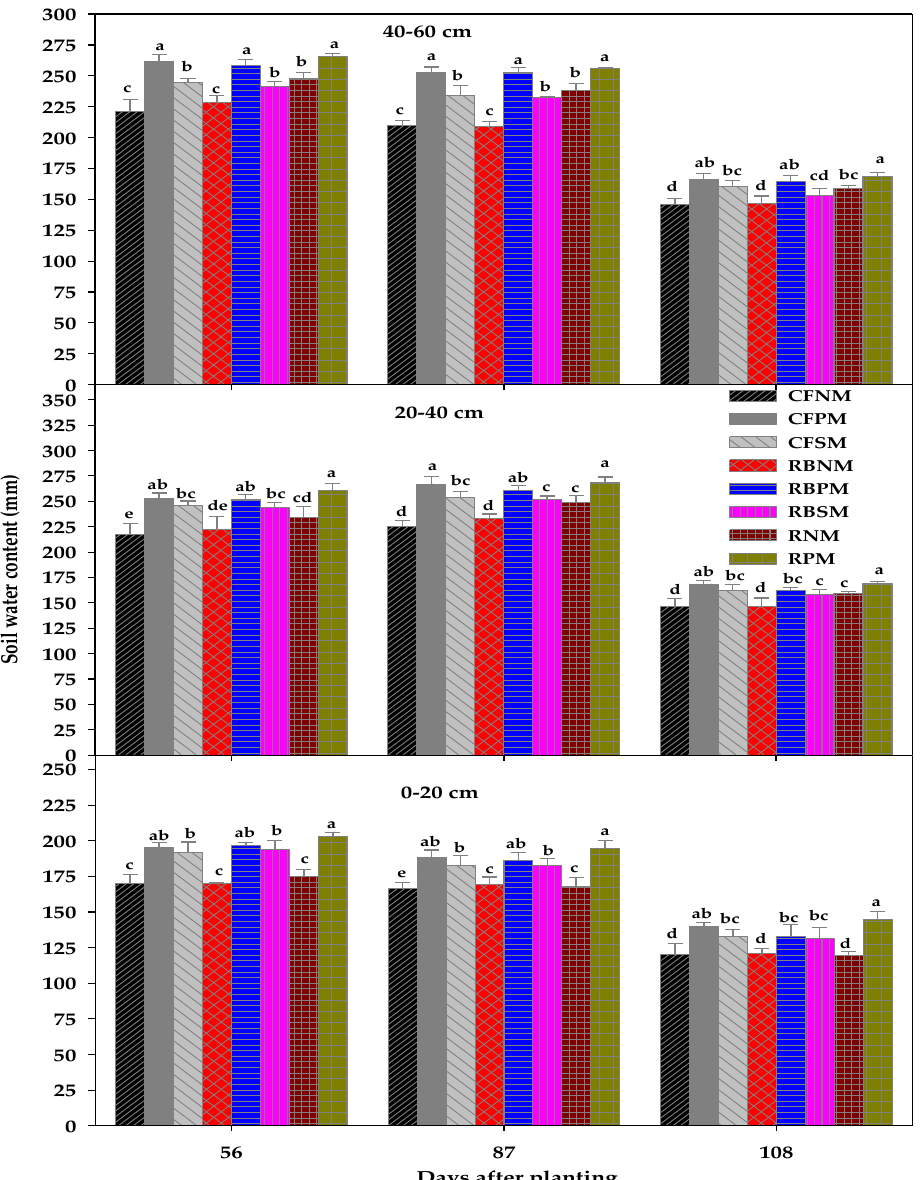
Figure 4. Effects of different planting patterns under full irrigation rate (1.00 ET) on soil water storage before irrigation at a 20 cm depth interval within 0–60 cm over two growing seasons at different durations (in days) after sowing. Conventional flat planting (CF) without mulching (CFNM); CF with plastic film mulch (CFPM); CF with wheat straw mulch (CFSM); raised-bed planting (RB) without mulch (RBNM); RB with plastic film mulch (RBPM); RB with wheat straw mulch (RBSM); ridge–furrow planting (RF) without mulch (RFNM); and RF with plastic film mulch on both ridges and furrows (RFPM). Bars with different letters are significantly different from each another on the basis of Duncan’s multiple range test at p ≤